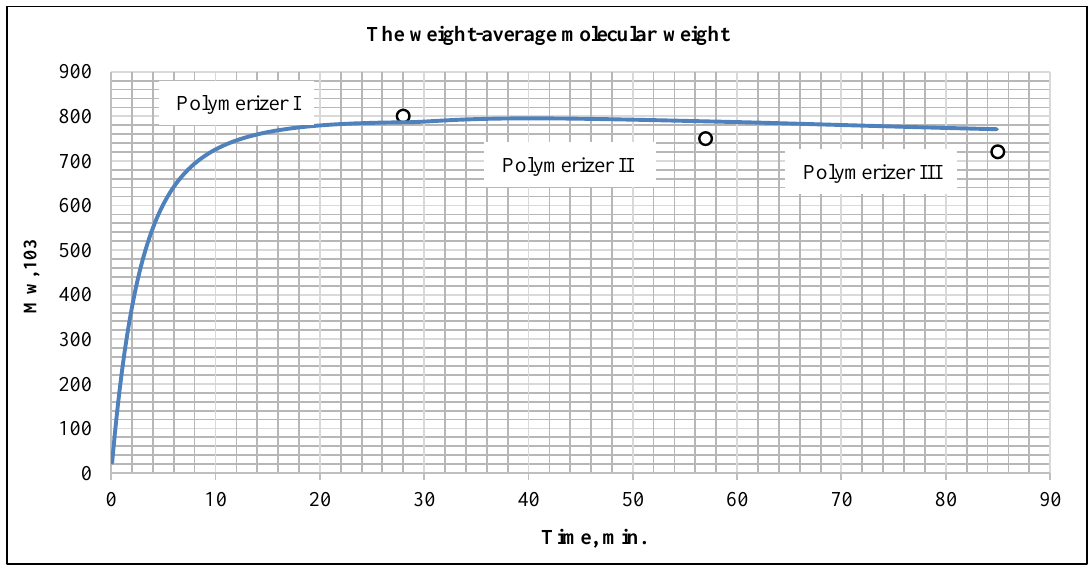
Figure 8. The dependence of the calculated average molecular weight on time for polyisoprene on the catalytic system 𝑵𝒅𝑪𝒍 𝟑 -nIPA-TIBA-Pip (line denotes the results of calculations, dots show the results of a laboratory